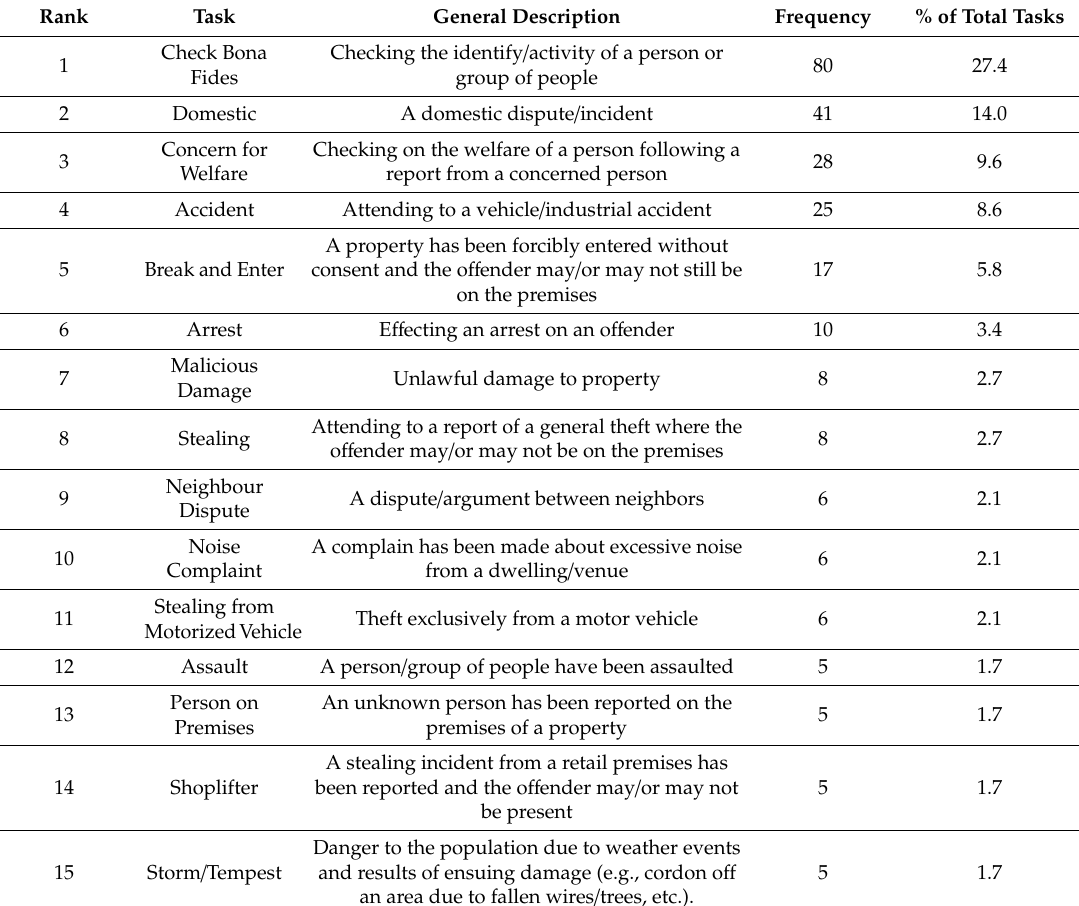
Table 2. Top 15 tasks attended by police o ffi cers during shifts, by frequency, as reported on the computor added dispatch (CAD)